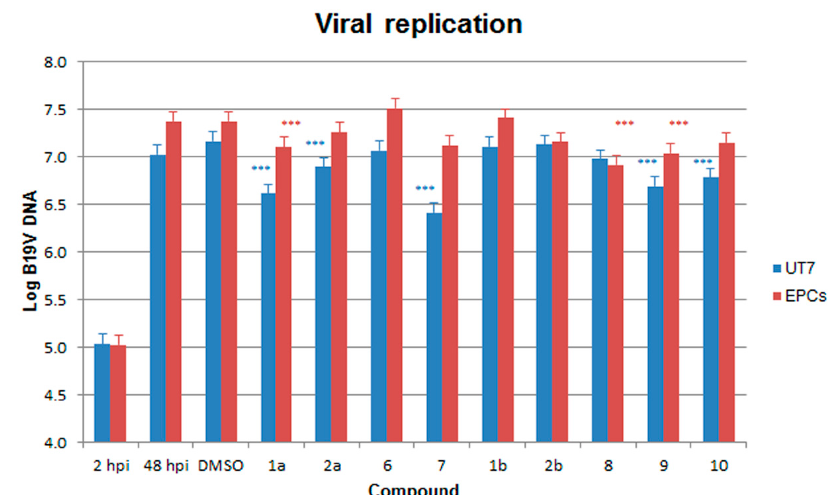
Figure 3. Amount of B19V DNA (Log geq/10 4 cells) in the different samples, at 2 hpi and at 48 hpi following a course of infection in the presence of different compounds as indicated. Data were collected from duplicate experiments; the statistical analysis was performed by one-way ANOVA (analysis of variance) followed by Dunnett’s multiple comparison (control medium with 1% DMSO). *** p value < 0.0001.